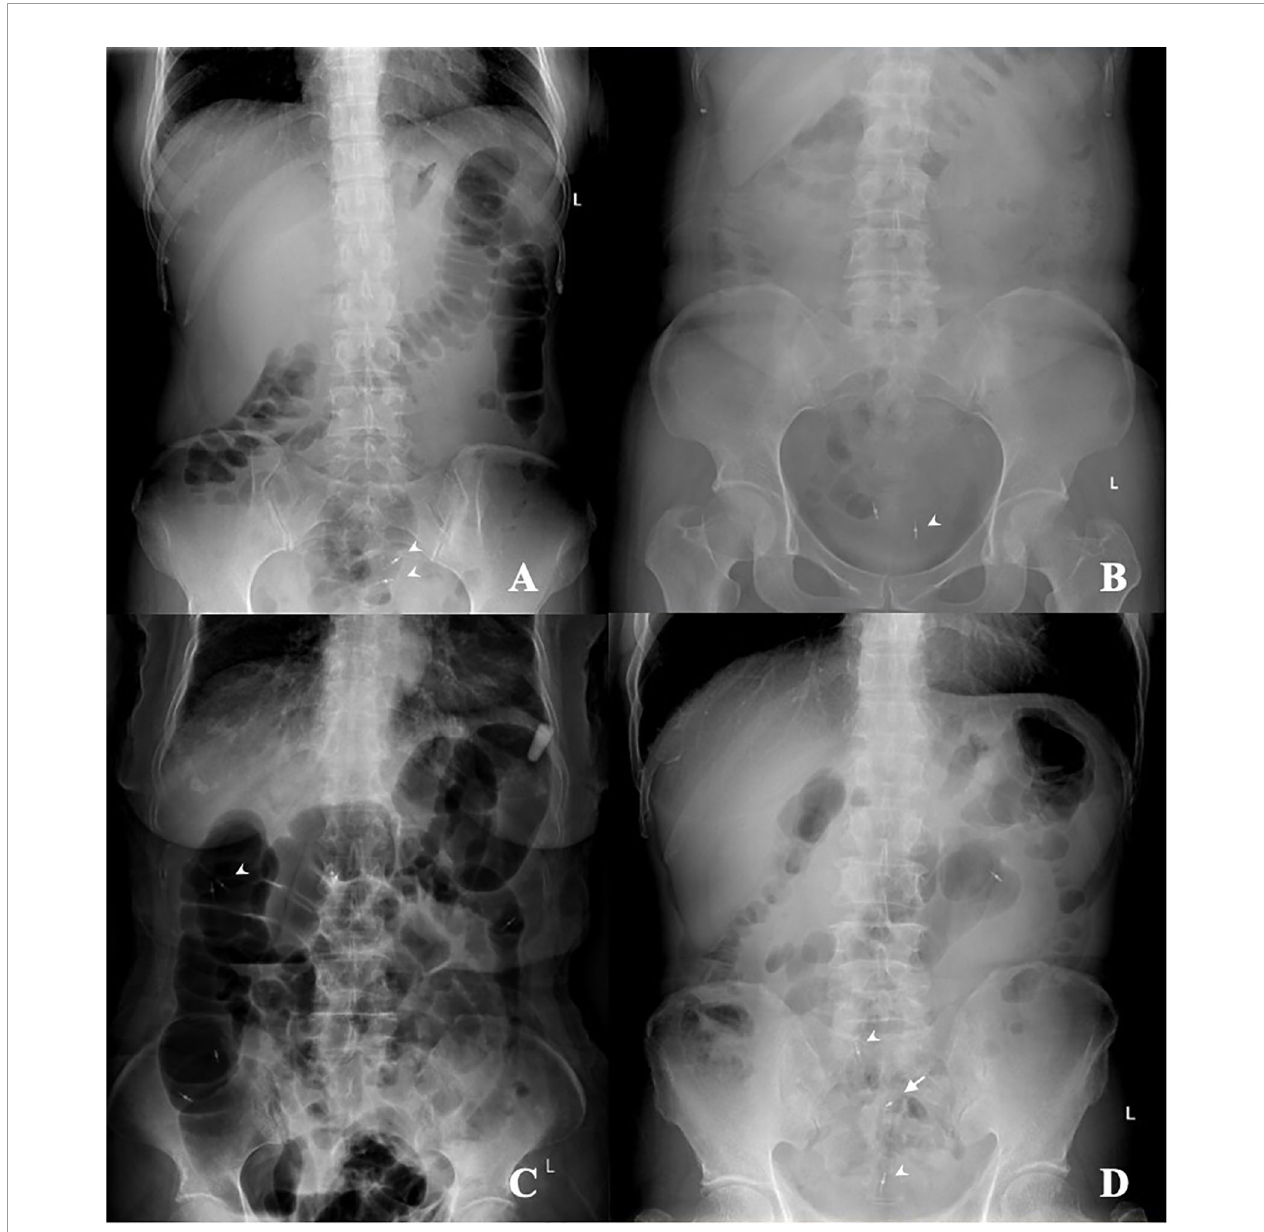
FIGURE 3 | The supine abdominal plain fi lm after clip placement for tumor localization. (A) The appropriately air-in fl ated colon and the clips (arrowhead) near the tumor in the upper rectum. (B) The poorly air-in fl ated colon and the clips (arrowhead) near the tumor in the rectosigmoid junction. (C) The over air-in fl ated colon and the overlapped lumen of the ascending colon and transverse colon, and the clips (arrowhead) failed to localize the tumor in the transverse colon. (D) Several clips in the sigmoid colon, with two clips (arrowhead) placed after polyp removal and one clip (arrow) placed near the tumor, which would create